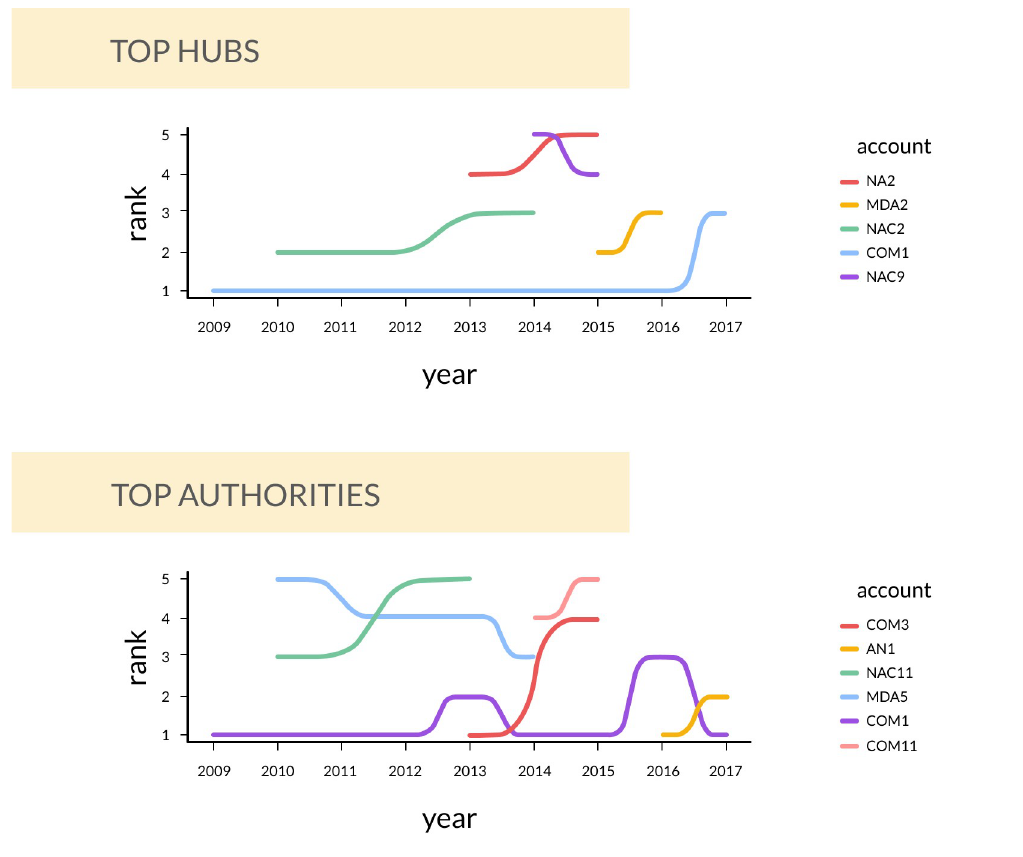
Fig 4. Bump charts demonstrating longitudinal patterns in top hubs and authorities of Twitter probiotics chatter from 2009–2017. Lower numbers on the y-axis indicate a higher rank. COM1 is the only account that is consistently present in both the top hubs amd authorities charts. COM (Commerical Organizations) are more prevalent as top authorities while having a minimal presence as top